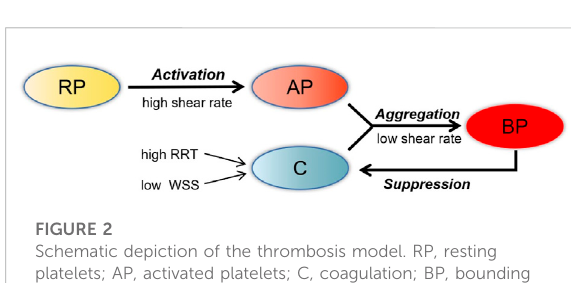
FIGURE 2 Schematic depiction of the thrombosis model. RP, resting platelets; AP, activated platelets; C, coagulation; BP, bounding platelets; RRT, relative residence time; WSS, wall shear